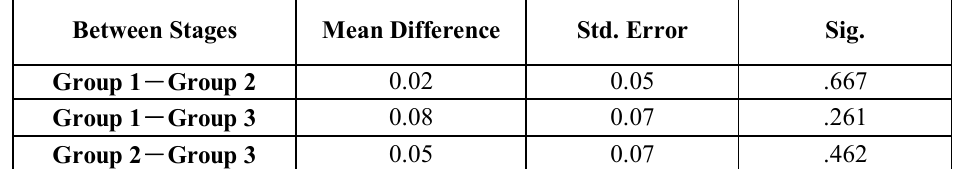
Table 3 – Multiple Comparisons between Groups in terms of TOA in Final